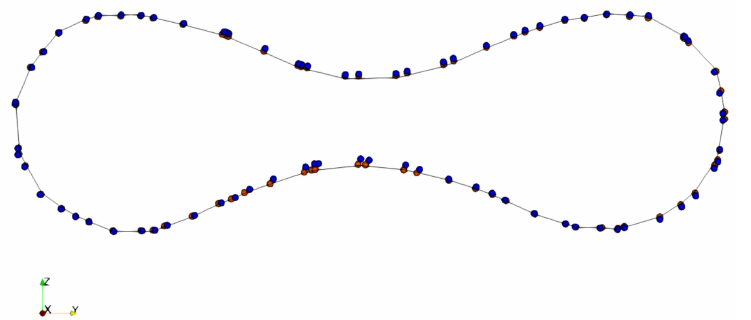
Figure 8. The impacts of computational mesh size on the simulated results of RBC deformation. The shape of the RBC membrane is shown in a symmetry plane orthogonal to the x direction at the time instance of 240 µ s. The position of the vertices of the RBC in Grid-1, Grid-2, and Grid-3 (see Table 2) are shown in blue points, red points, and the solid line, respectively. The shape of the RBC is nearly identical under different computational